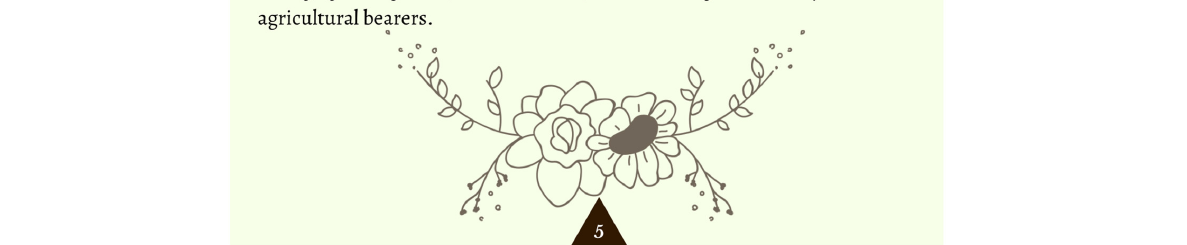
FIGURE2 Culinary expert introduction and recipe forward, providing readers with the cultural background of the dish and importance of its heart-healthy modifications.